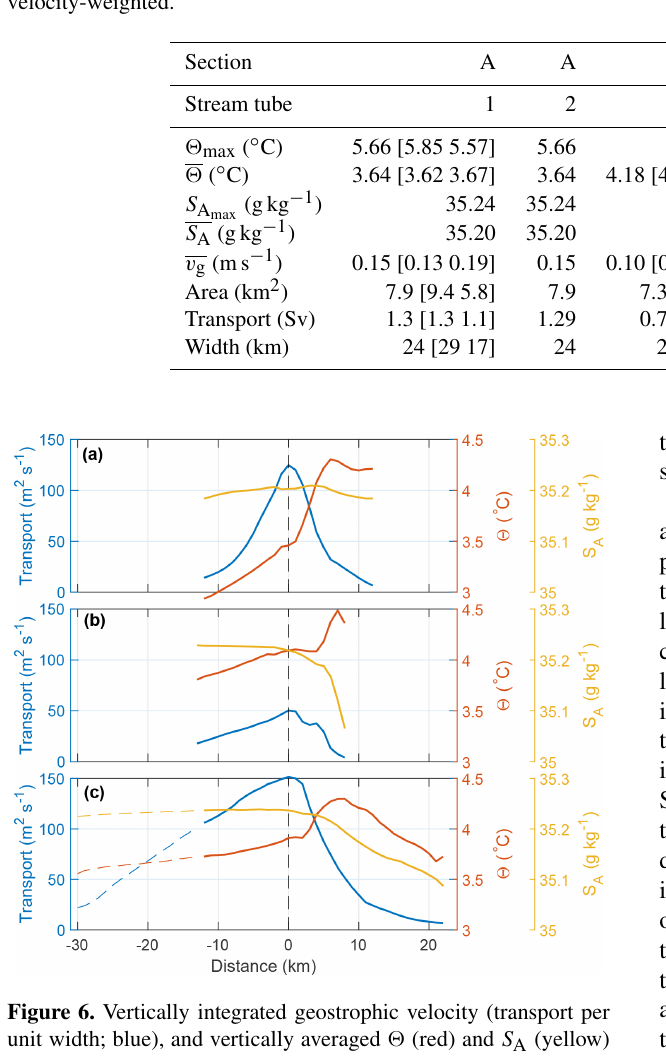
Table 2. Properties in stream tubes 1 and 2 in sections A (northernmost), B and C (southernmost). The bounds for stream tube 1 given in square brackets are calculated using tube widths from the background velocity thresholds of 0.02 and 0.08ms − 1 (no bracket means no change in value). Stream tube 2 conserves a volume transport of 1.3Sv to within 10%. Stream tube averages, indicated by overbars, are velocity-weighted.